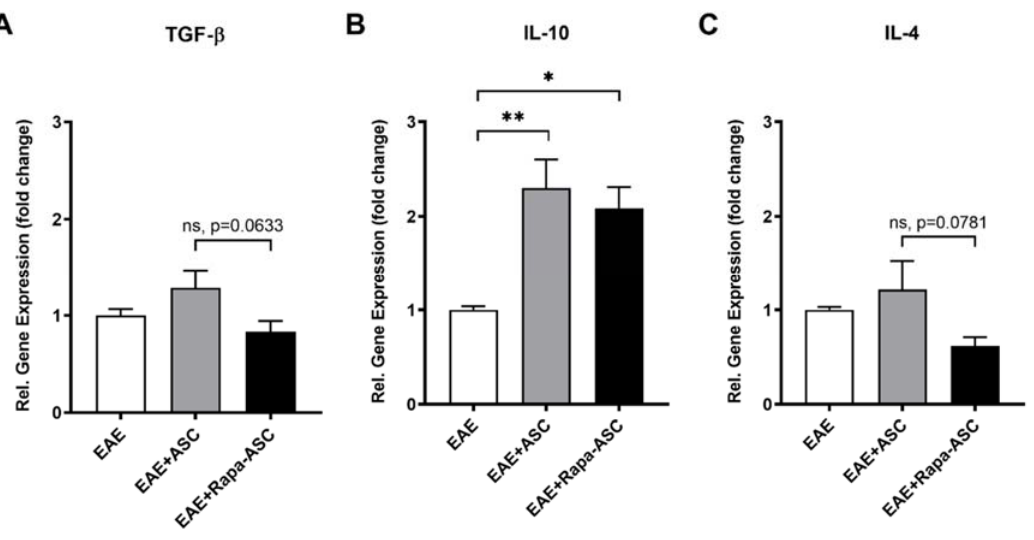
Figure 4. Gene expression analysis of T helper cell cytokines in the EAE spinal cord is altered by ASC treatments. Whole EAE spinal cords were analyzed using RT ‐ qPCR for the T helper cell ‐ derived cytokines TGF ‐β ( A ), IL ‐ 10 ( B ), and IL ‐ 4 ( C ). Data are presented as the mean ± SEM. Data are normalized to the housekeeping gene β‐ actin and represented as the relative fold change ± SEM over vehicle ‐ treated EAE controls. Statistical analysis was performed using a one ‐ way analysis of variance (ANOVA) and Tukey’s post ‐ hoc multiple comparisons test. Statistical differences between groups are marked with * p < 0.05; ** p < 0.01. TGF ‐β , transforming growth factor ‐ beta; IL ‐ 10, interleukin ‐ 10; IL ‐ 4, interleukin ‐ 4.